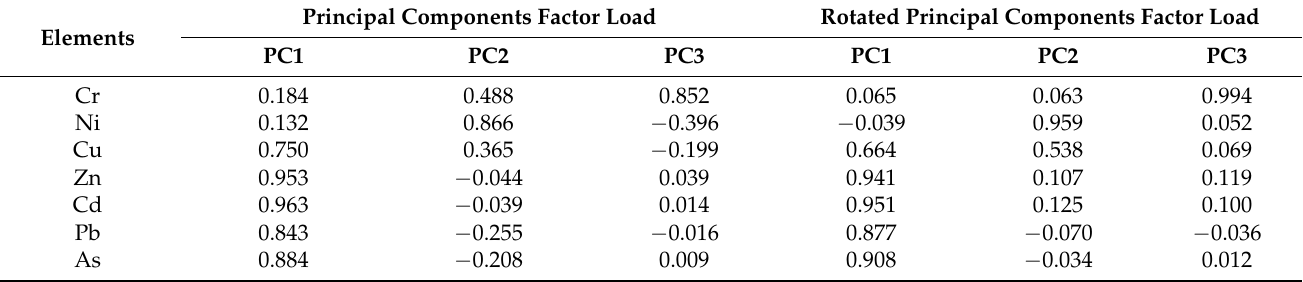
Table 7. Composition matrix of heavy